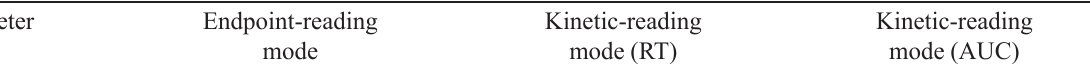
TABLE I - Comparison of method validation results for microplate assay using endpoint-reading, kinetic-reading (RT) and kinetic-